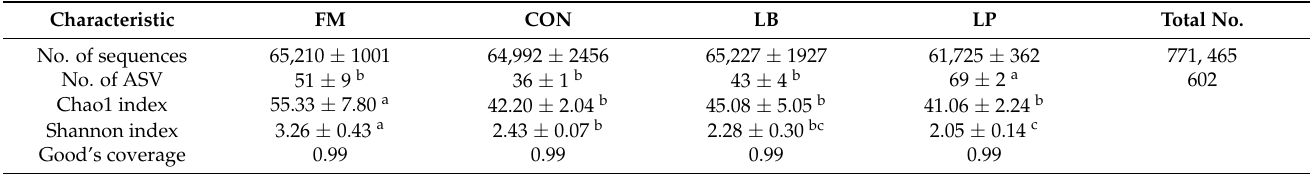
Table 5. Characteristics of amplicon libraries in the fungal community.